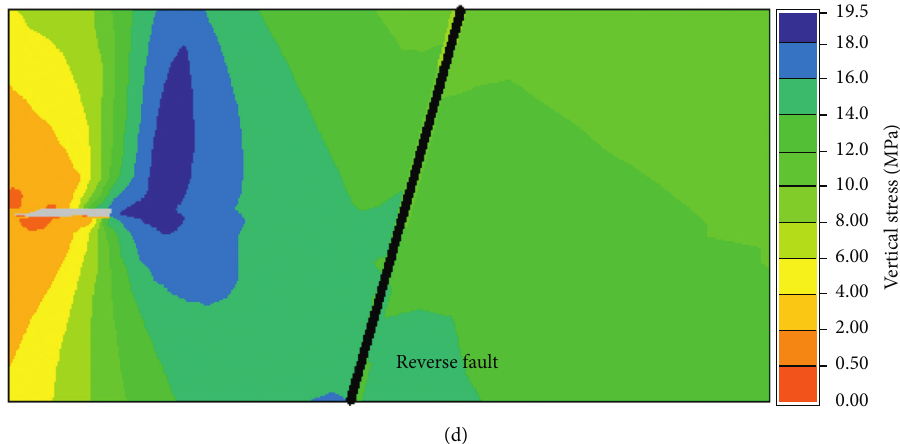
Figure 9: Stress distribution when the distance between working face and reverse fault is 40m with different dip angles. (a) The dip angle of reverse fault is 30 ° . (b) The dip angle of reverse fault is 45 ° . (c) The dip angle of reverse fault is 60 ° . (d) The dip angle of reverse fault is 75 °